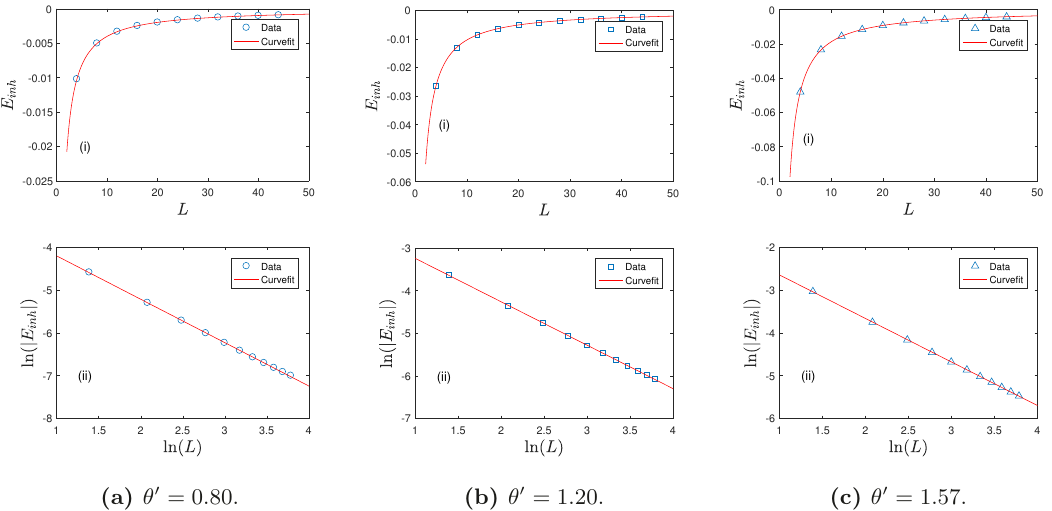
˜ β [or inh tends to